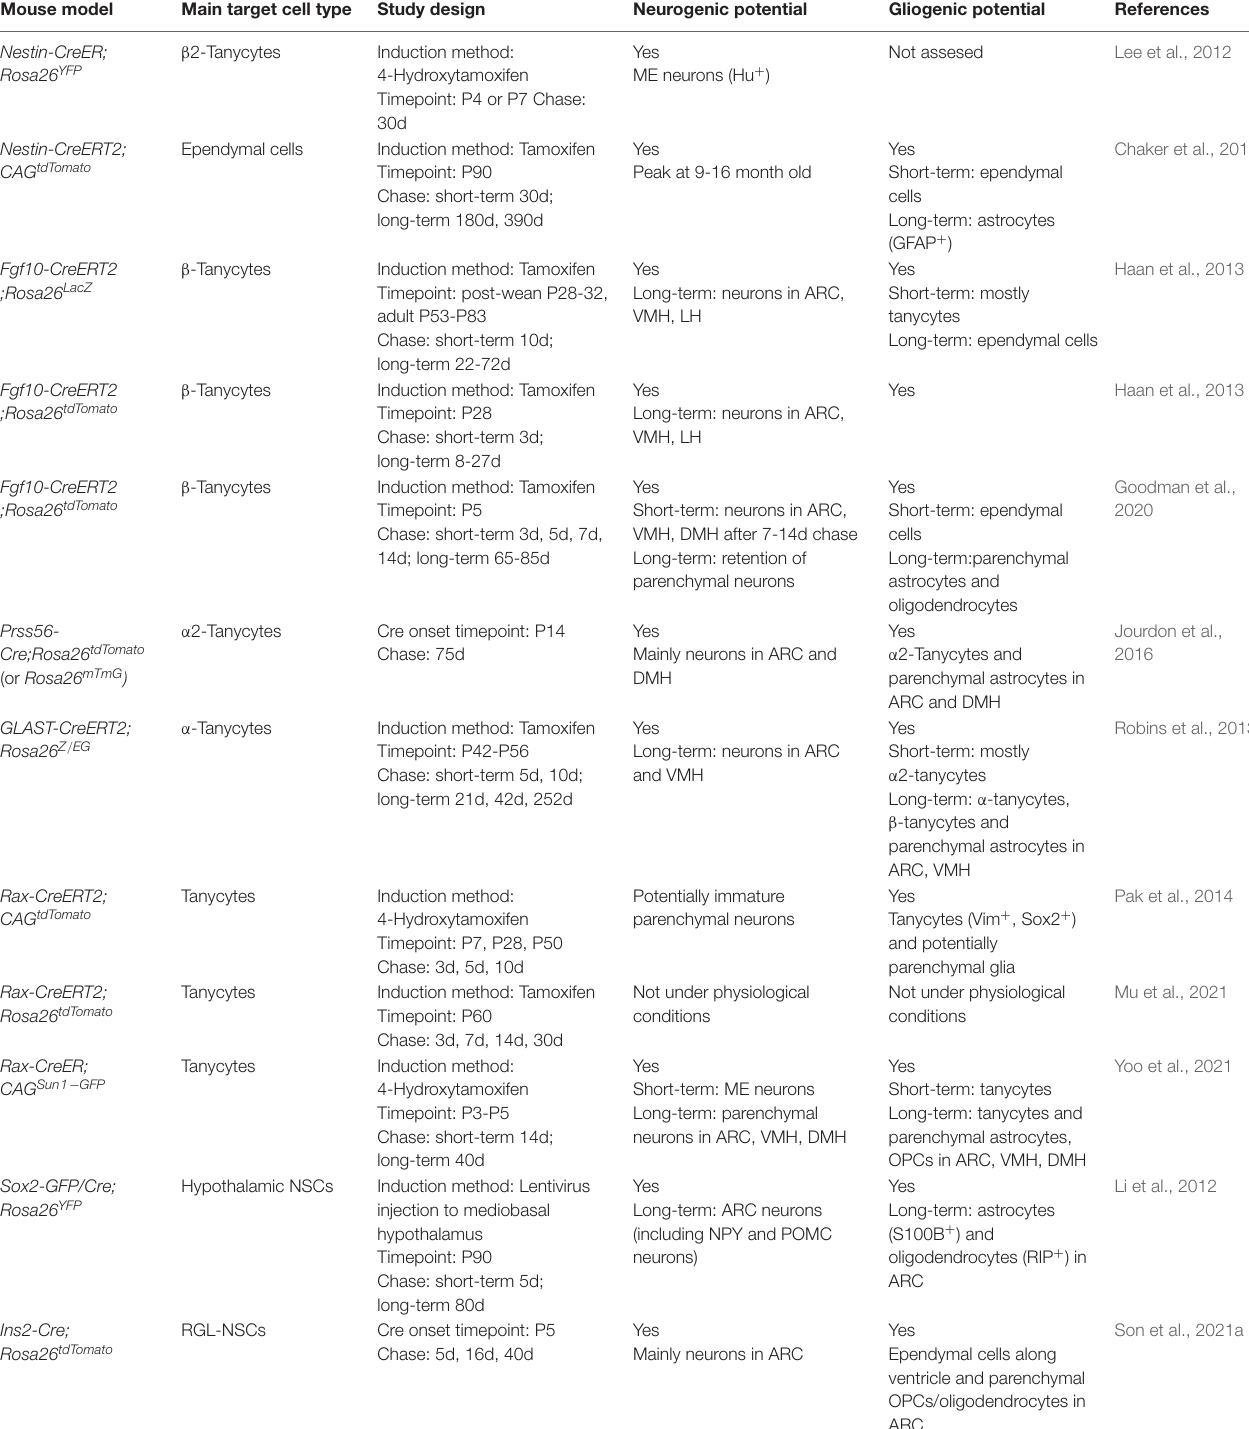
TABLE 2 | Summary of lineage tracing studies of postnatal hypothalamic neurogenesis from radial glia-like cells. Mouse